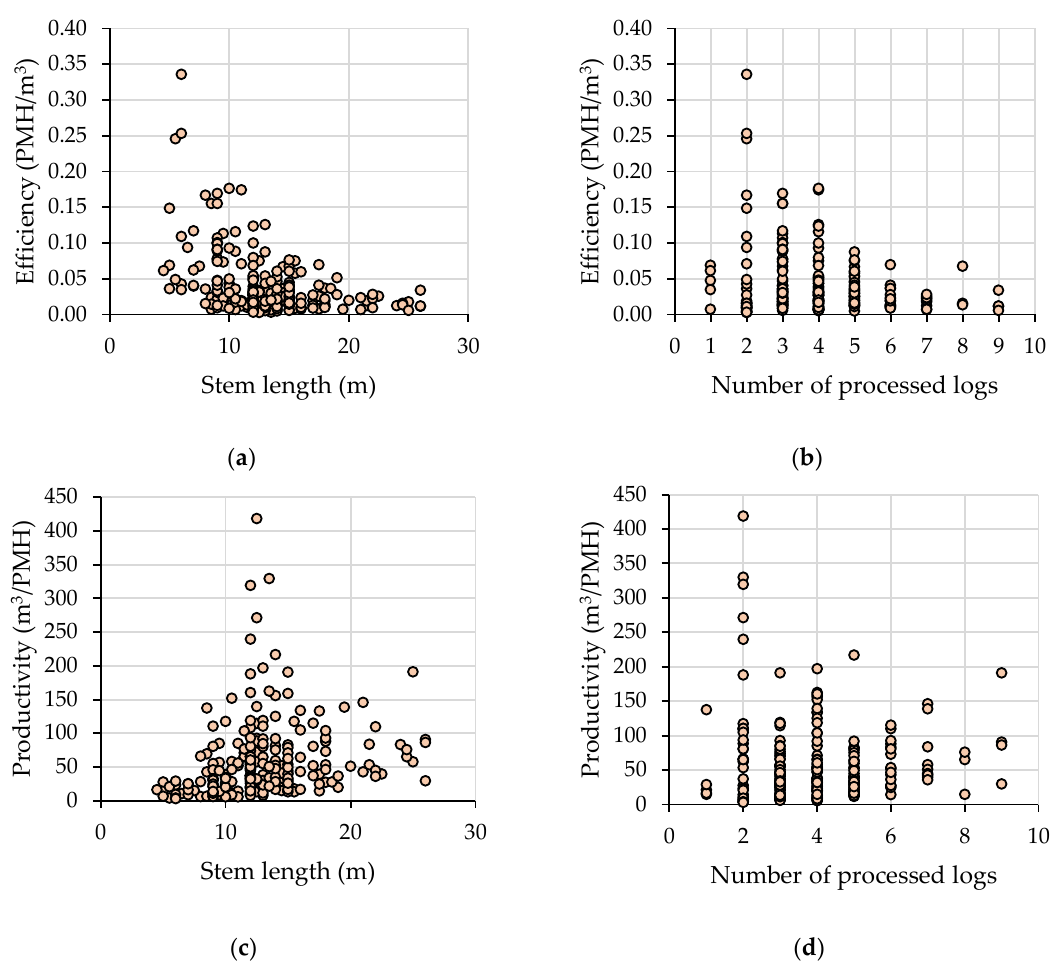
Figure A4. Scatter plots of the variation in net efficiency and productivity plotted against the relevant input and output variables: ( a ) efficiency against stem length; ( b ) efficiency against number of processed logs; ( c ) productivity against stem length; ( d ) productivity against number of processed logs; Note: data have failed normality and homoskedasticity assumptions.